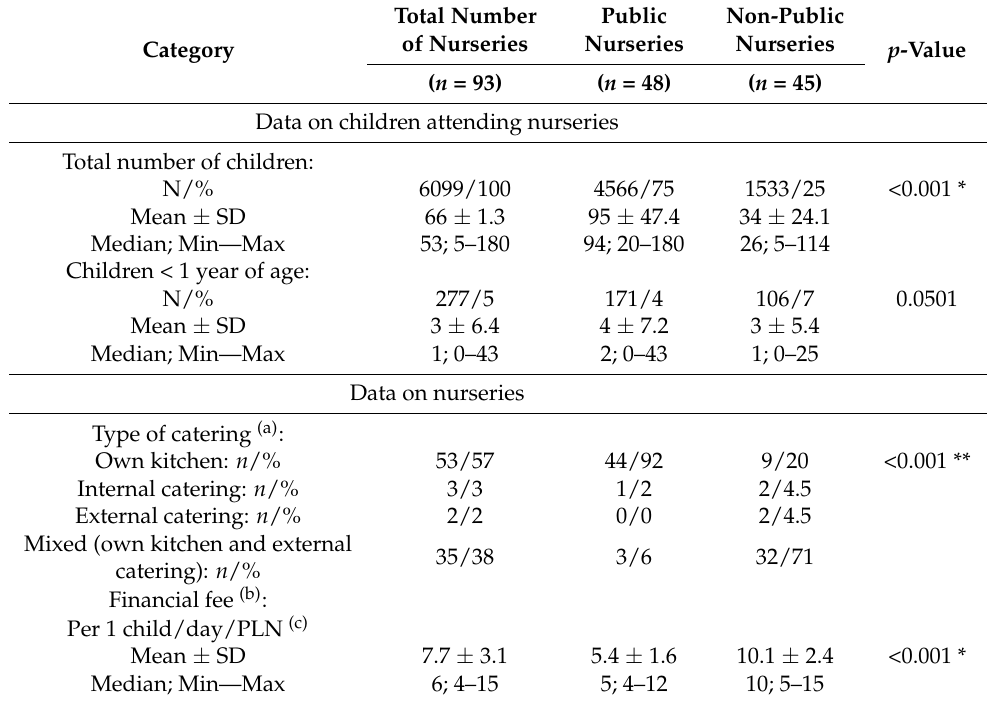
Table 1. General characteristics of